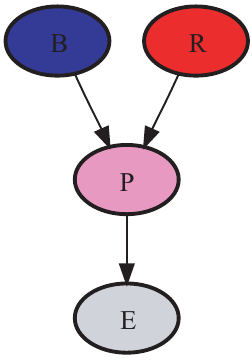
Fig. 1. Illustration of the rate approximation example (see